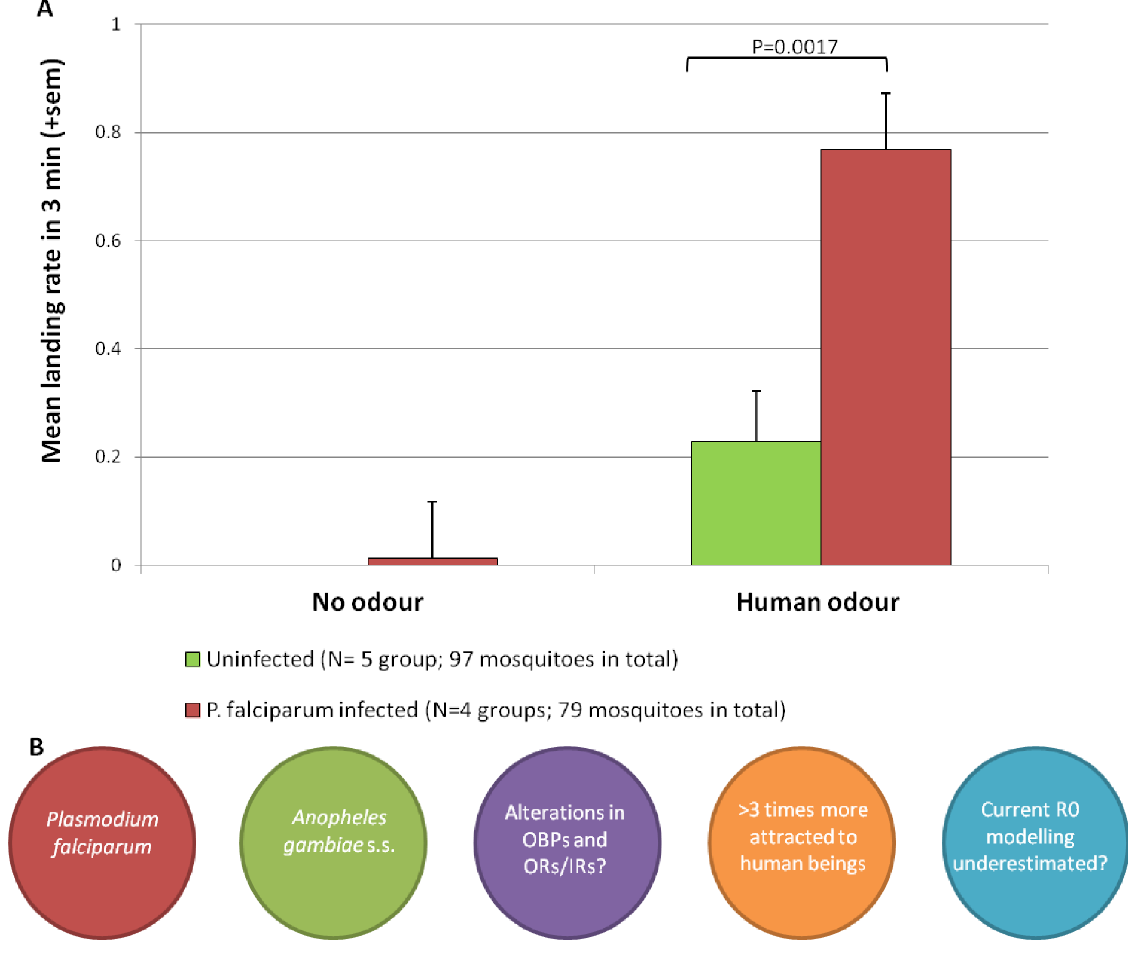
Figure 1. Attraction of malaria infected mosquitoes to human odor. ( A ) Total number of landings by uninfected (green bars) and P. falciparum infected (red bars) An. gambiae s.s. females in response to no odor (left bars) or human odor (right bars). Error bars represent the standard error of the mean. ( B ) Simplified overview of our hypothesis on the effect of P. falciparum infection of An. gambiae s.s. on human malaria risk via alterations in the olfactory system of the vector (OBPs: odorant-binding proteins, ORs/IRs: olfactory and ionotropic receptors; R0: the basic reproductive number).